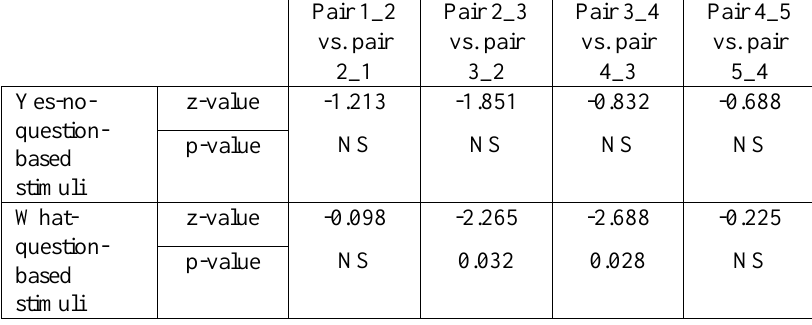
Table XII. z- and p-values of four Wilcoxon matched pairs signed rank tests comparing the difference between hit rate and false alarm rate for each pair with the conditions AB and BA orders of